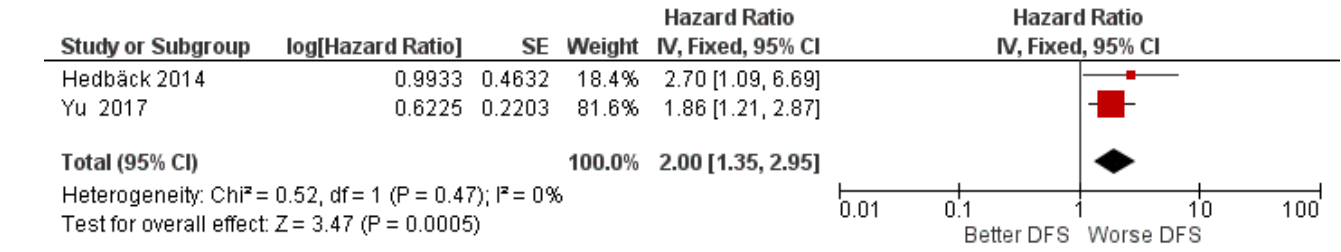
Figure 2. Forest plot of the fixed-effects model of the meta-analysis of the first outcome.